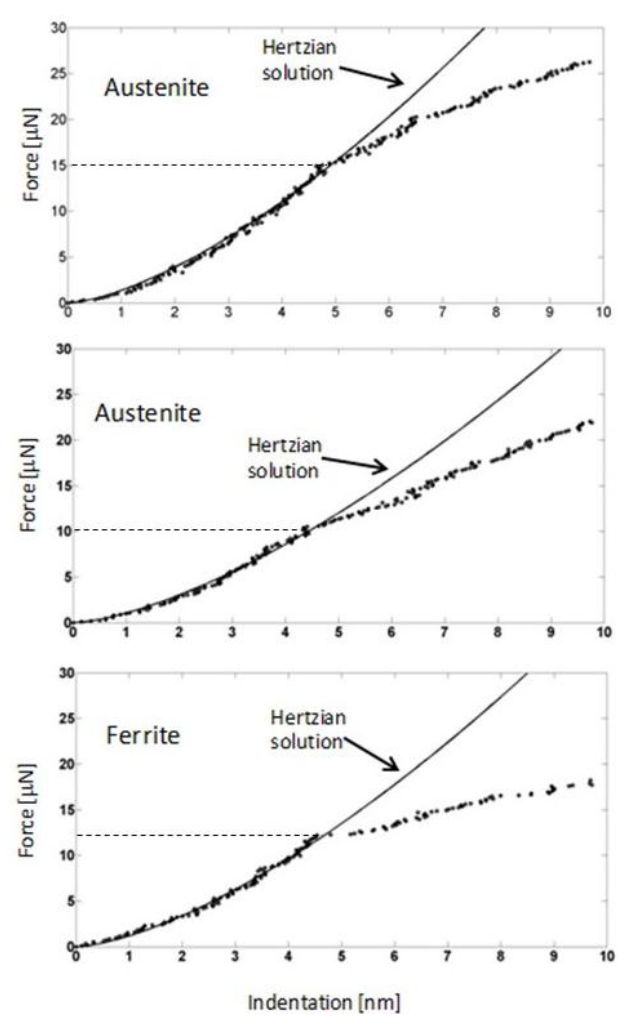
Figure 16. Approach force curves obtained by AFM-based nano-indentation in either bainitic ferrite or austenite, in a nanobainitic structure treated at 300 °C, described in reference [15].